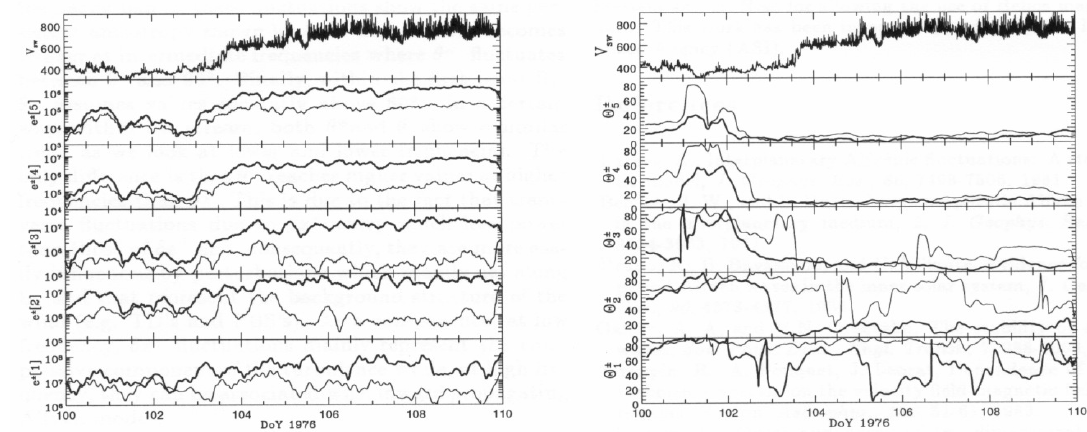
Figure 50: Left panel: wind speed profile is shown in the top panel. Power density associated with e + (thick line) and e – (thin line), within the five frequency bands chosen, is shown in the lower panels. Right panel: wind speed profile is shown in the top panel. Values of the angle 𝜃 ± between the minimum variance direction of 𝛿𝑧 + (thick line) and 𝛿𝑧 − (thin line) and the direction of the ambient magnetic field are shown in the lower panels, relatively to each frequency band. Image reproduced by permission from Bruno et al. (1996), copyright by